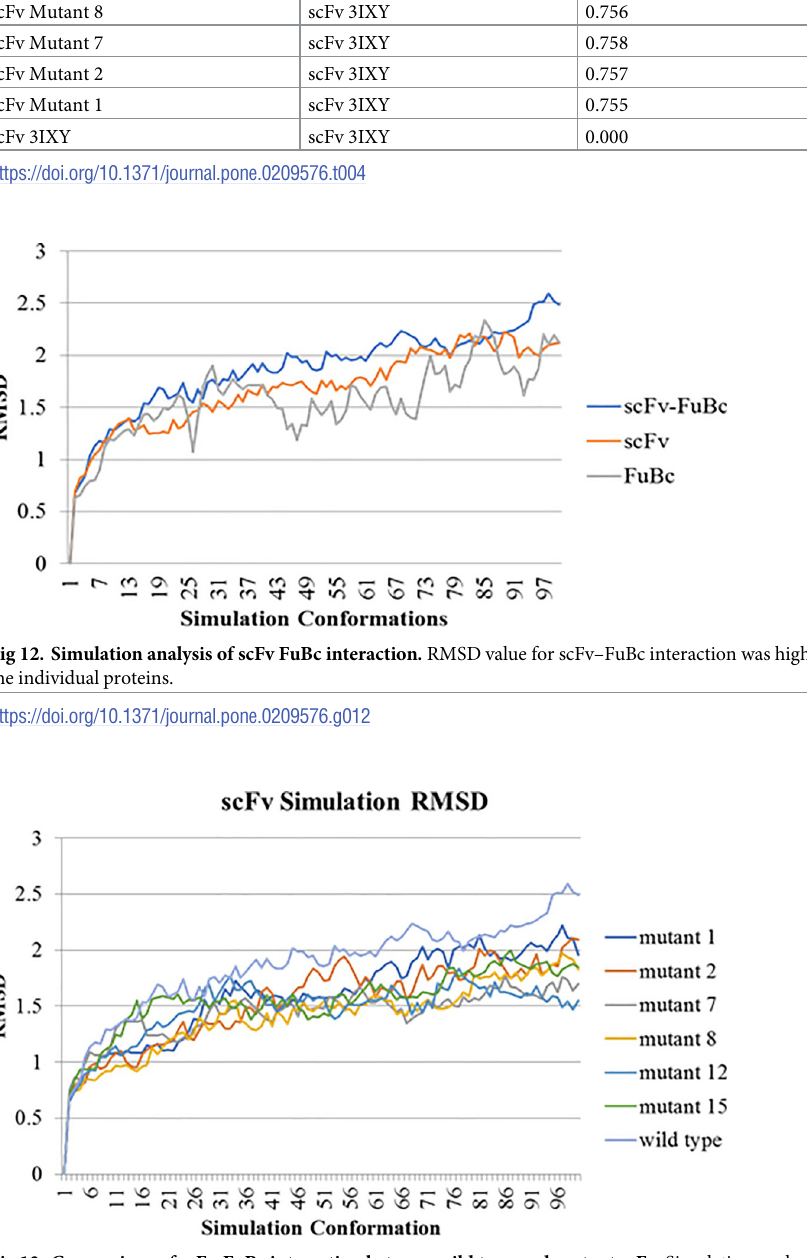
Fig 13. Comparison of scFv-FuBc interaction between wild type and mutant scFv. Simulation analysis of all the mutants showed less RMSD values as compare to wild type scFv.